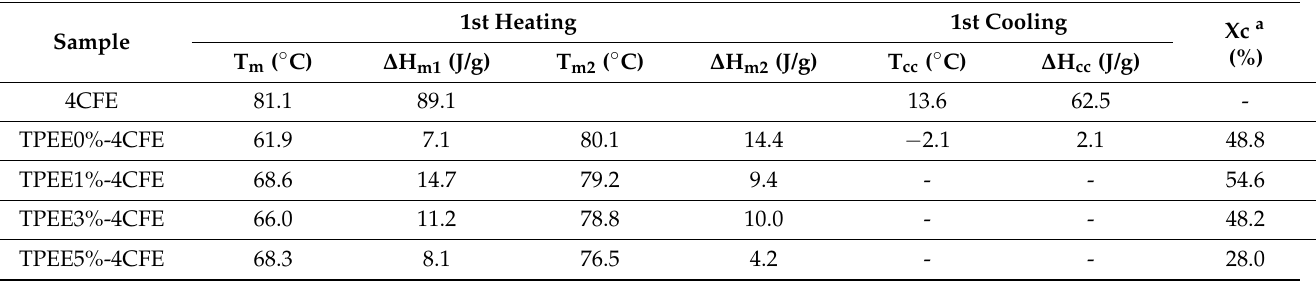
Table 1. DSC data of 4CFE and